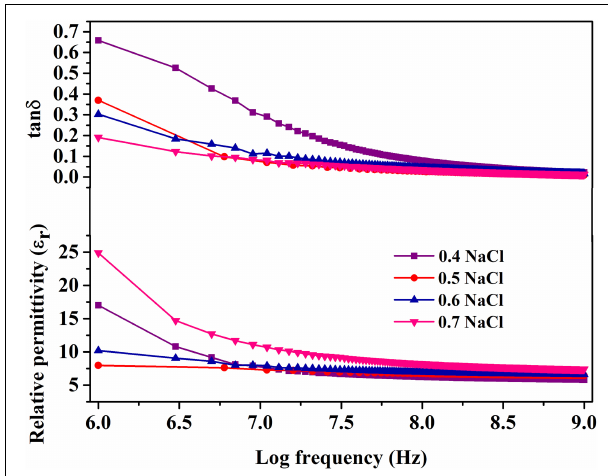
FIGURE 8 | Dependence of relative permittivity and tan δ with NaCl volume fraction.